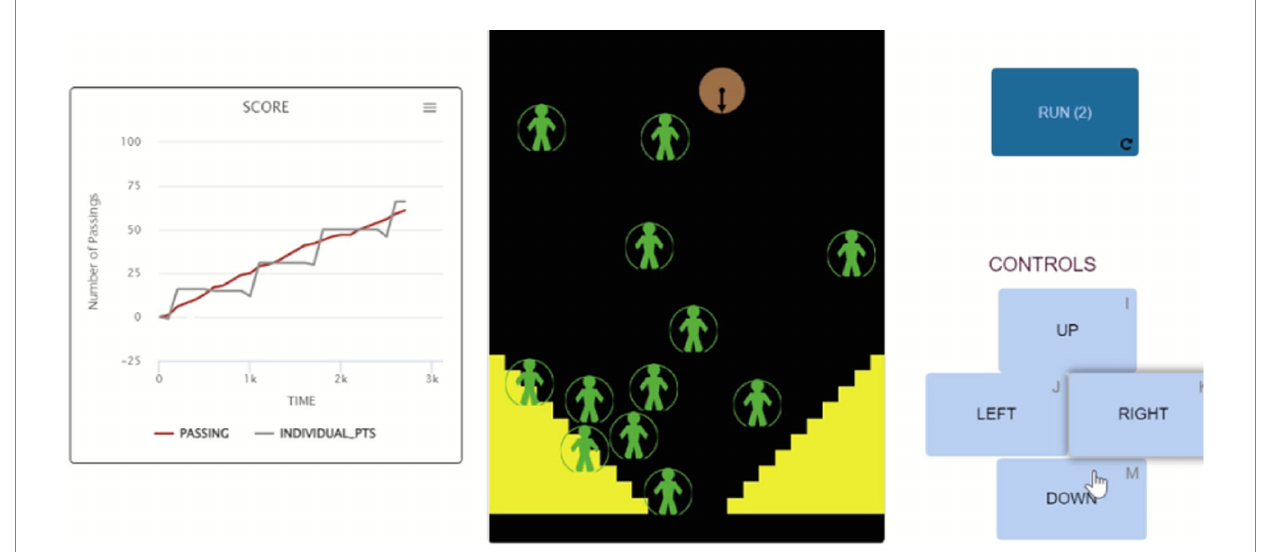
FIGURE 3 the participatory simulation of evacuation through a bottleneck: The brown circle is controlled by the user with the up-down-left–right control keys (right). The graph (left) shows the points gained by the user (20 point for each successful pass, minus one point taken away by each collision) in the gray curve, and the overall passing rate in the red curve.